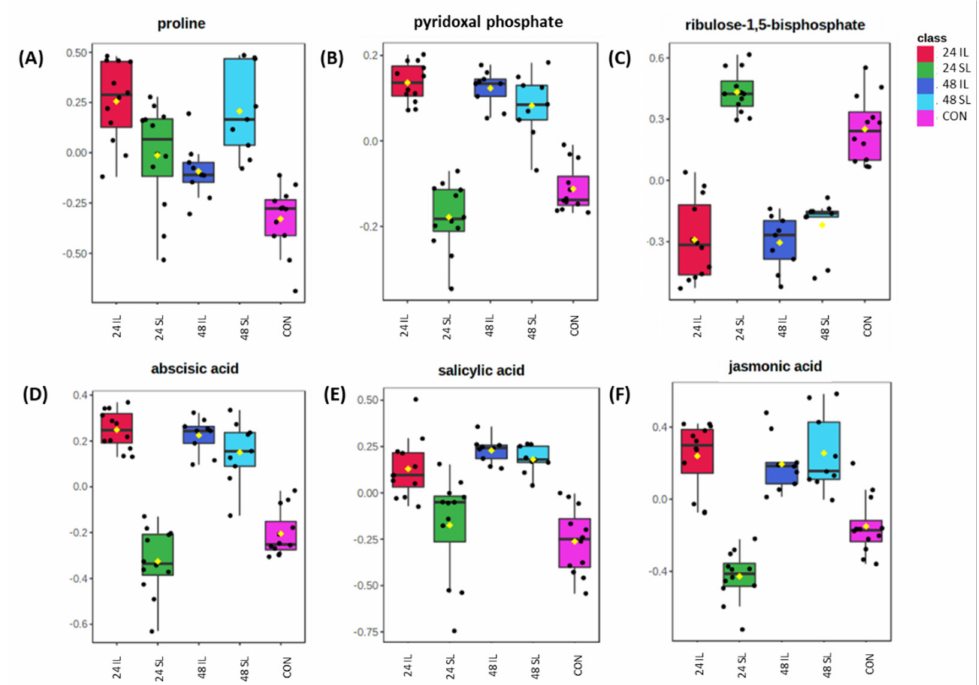
Figure 4. Metabolites varying in Black Pepper ( Piper nigrum L.) leaves challenged with Phytophthora capsici. Key exemplar metabolites exhibiting significant variations ( A ) Proline ( B ) pyridoxal phosphate ( C ) ribulose-1,5-bisphosphate ( D ) abscisic acid ( E ) salicylic acid and ( F ) jasmonic acid in Piper nigrum control leaf (CON), Phytophthora capsici infected Piper nigrum infected leaves (IL) and leaf immediately above the infection site-systemic leaves (SL) at 24 h and 48